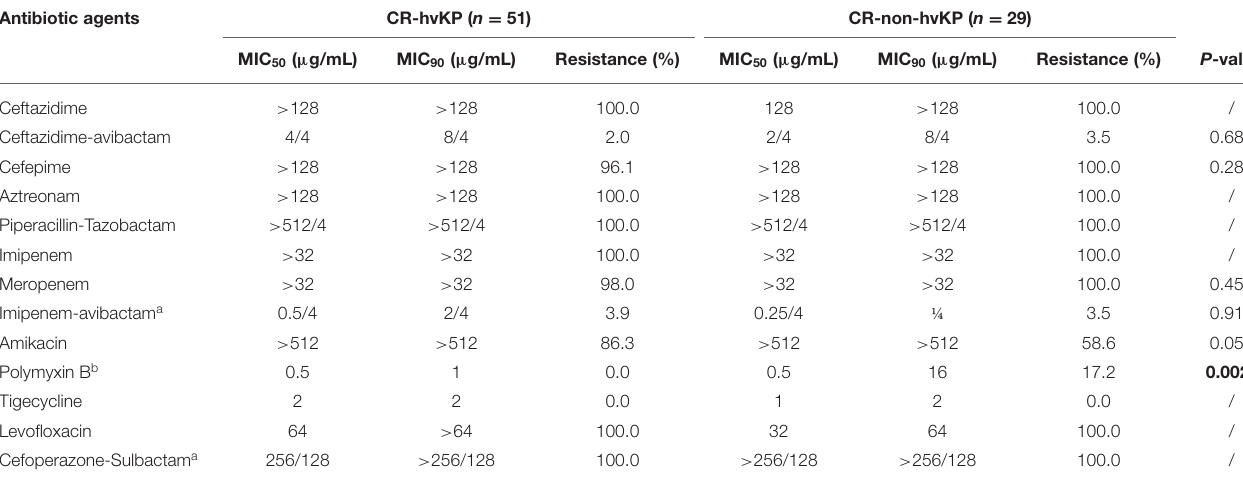
TABLE 2 | Susceptibility of CR-hvKP and CR-non-hvKP strains against different antimicrobial agents. Antibiotic agents